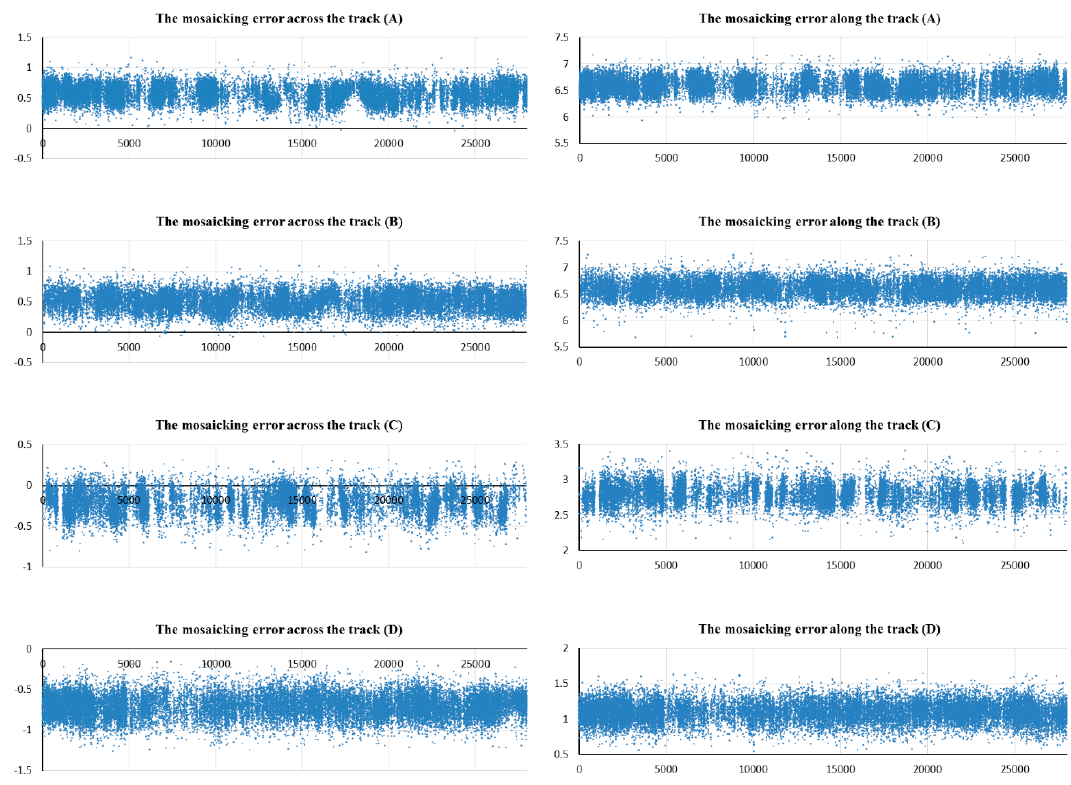
Figure 7. Mosaicking error for the camera overlap region with line number based on original RFM. Table 4. Mosaic accuracy of the camera overlap region using different